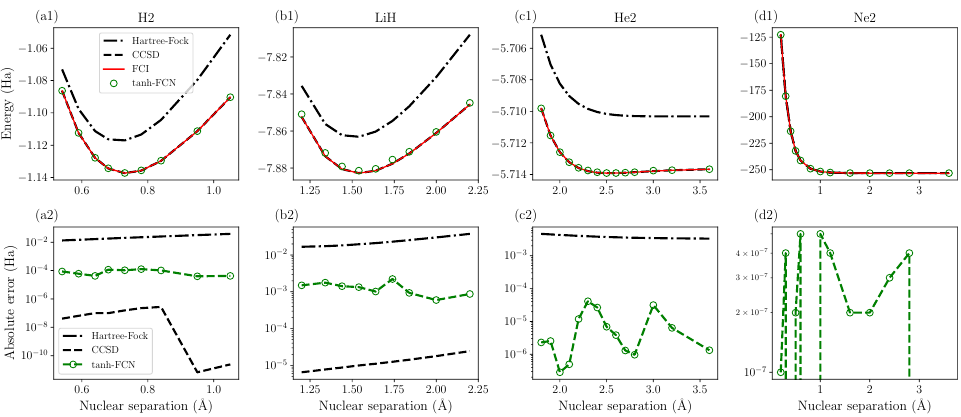
Figure 3. Potential energy surfaces of ( a1 ) H 2 , ( b1 ) LiH, ( c1 ) He 2 and ( d1 ) Ne 2 . We have used N h / N v = 2 for H 2 , He 2 , Ne 2 and N h / N v = 4 for LiH, which are sufficient for our tanh-FCN to reach chemical precision. We have also used N s = 2 10 4 for both molecules during the training. ( a2 ), × ( b2 ), ( c2 ) and ( d2 ) show the absolute error with respect to the FCI energy for H 2 , LiH, He 2 and Ne 2 respectively. We have used the STO-3G basis set for H 2 , LiH and Ne 2 , and the 6-31G basis set (using a (2e,4o) active space) for He 2